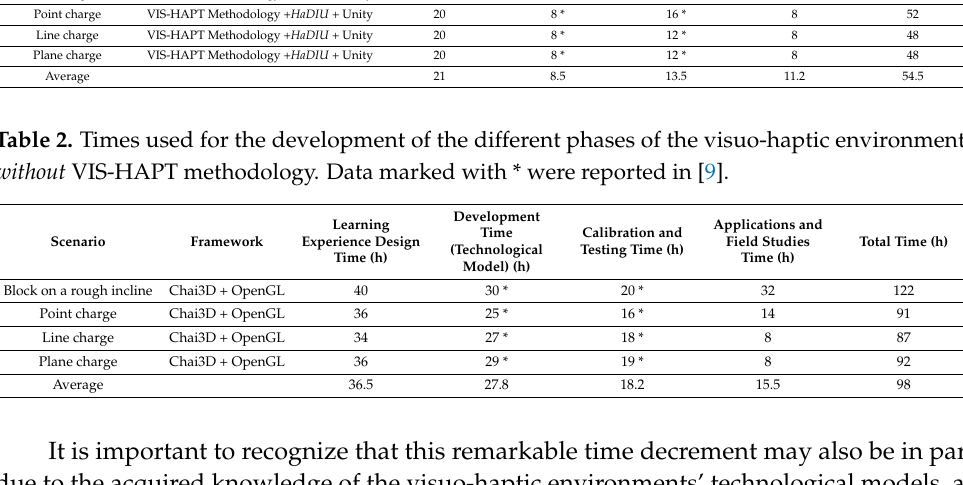
Table 1. Times used for the development of the different phases of the visuo-haptic environments using the VIS-HAPT and HaDIU architecture. Data marked with * were published by [9]. Learning Scenario Framework ExperienceDesign Time(h) Model)(h)